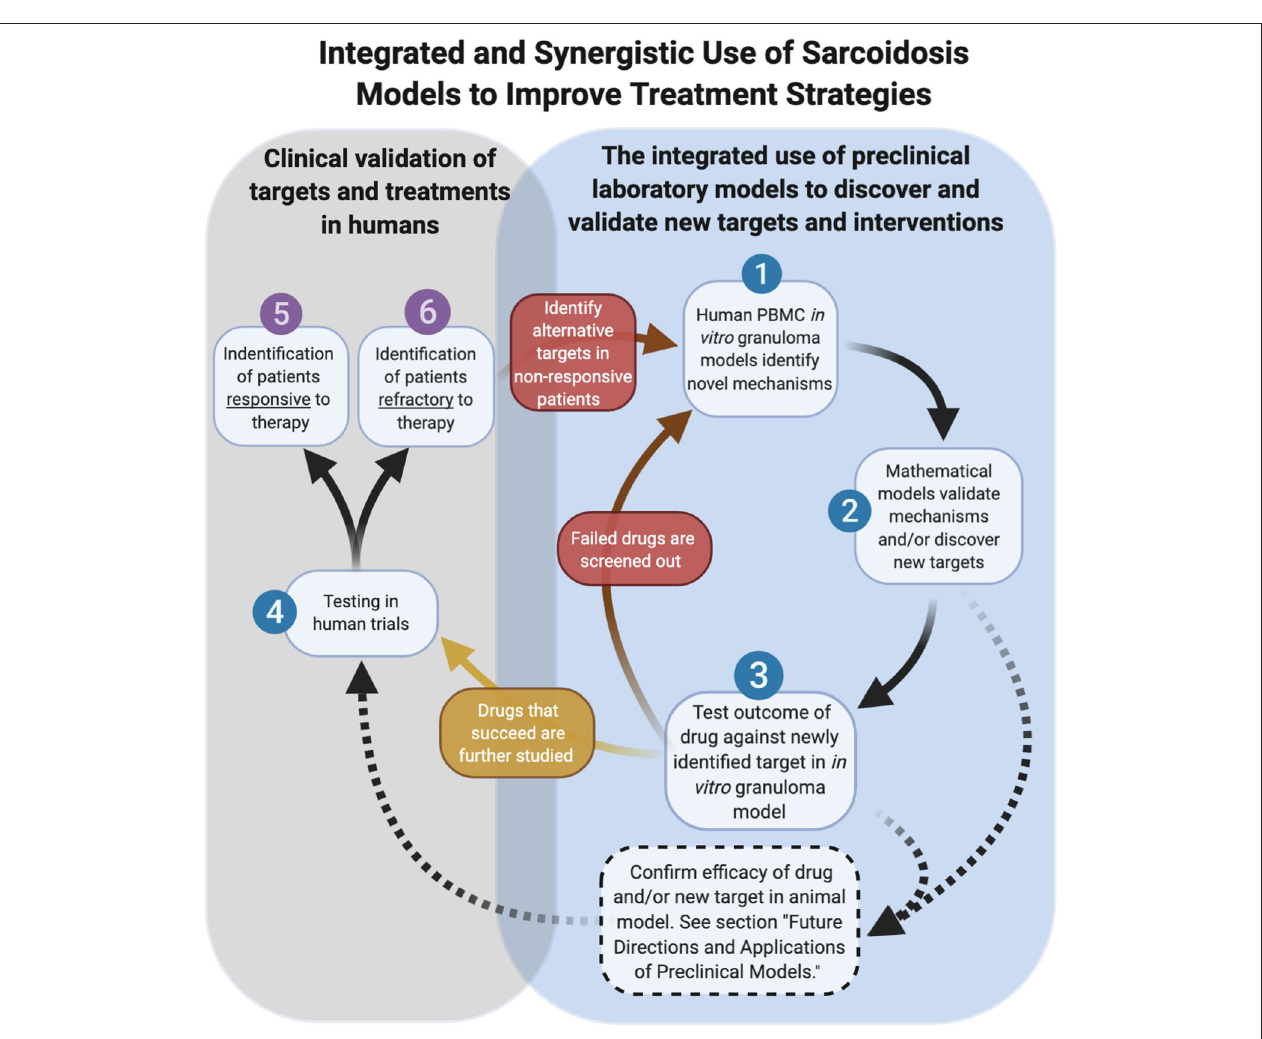
FIGURE 7 | Integrated and synergistic use of sarcoidosis models. Dashed arrows represent future pathways dependent on animal model advancements.